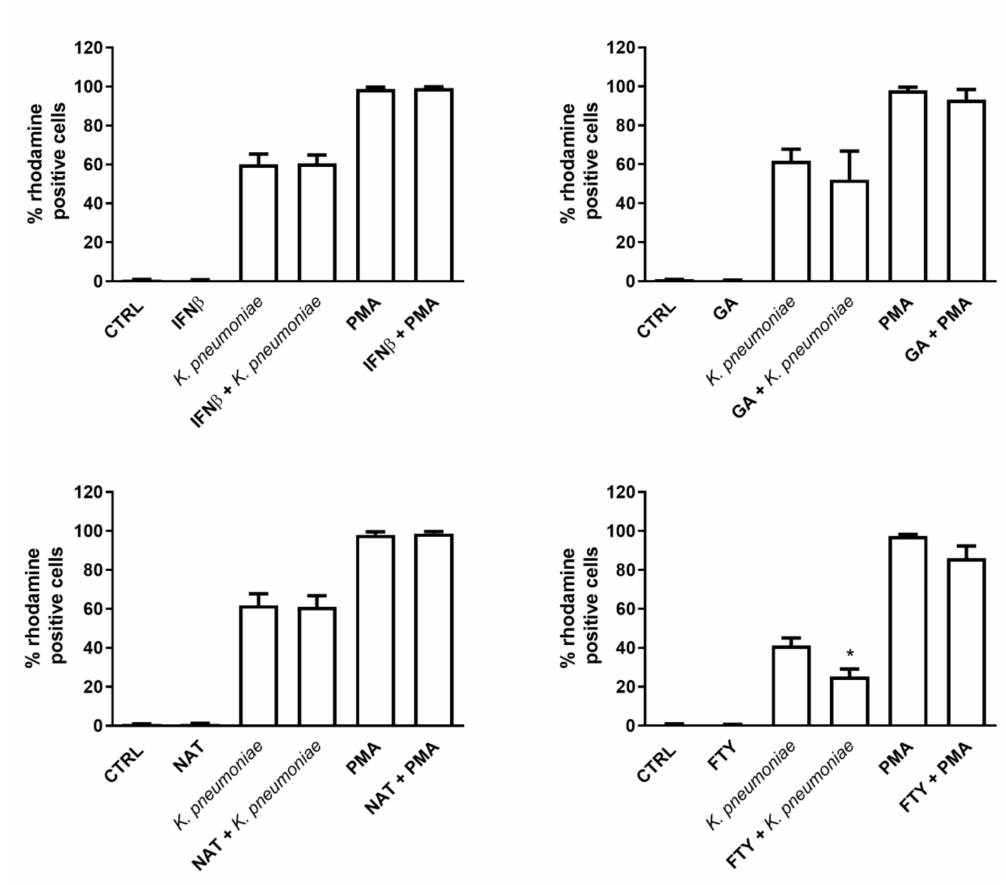
Figure 3. FTY exerts an inhibitory e ff ect on intracellular ROS production. Freshly isolated human PMNs were incubated with or without the indicated DMT for 60min at 37 ◦ C and then exposed to K. pneumoniae (10:1) or 5 µ M PMA for 30 min. Cells were loaded with DHR 123, and the intracellular production of ROS was assessed by FACS analysis. The percentage of PMNs expressing DHR 123 fluorescence is shown on the y axis. Data are shown as mean ± SEM from at least three independent experiments, * p < 0.05 as compared to the K. pneumoniae -stimulated sample without FTY, by using the unpaired